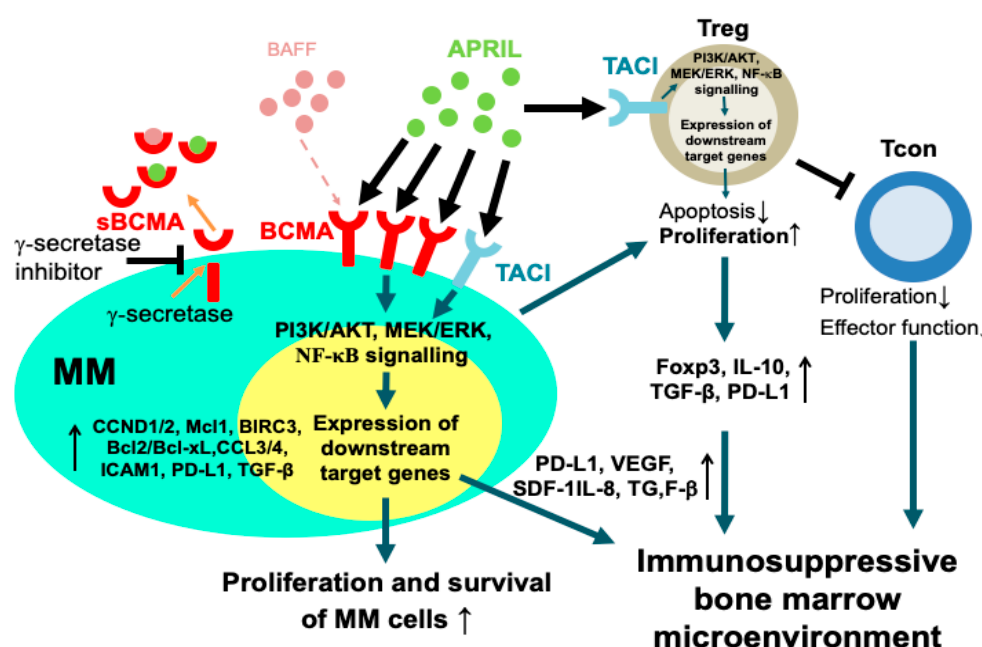
Figure 1. The A-proliferation inducing ligand / B cell maturation antigen (APRIL / BCMA) pathway Figure 1. The A ‐ proliferation inducing ligand/B cell maturation antigen (APRIL/BCMA) pathway and